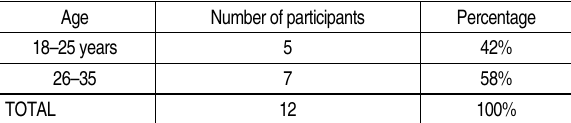
Table 2. Age distribution of participants in the study